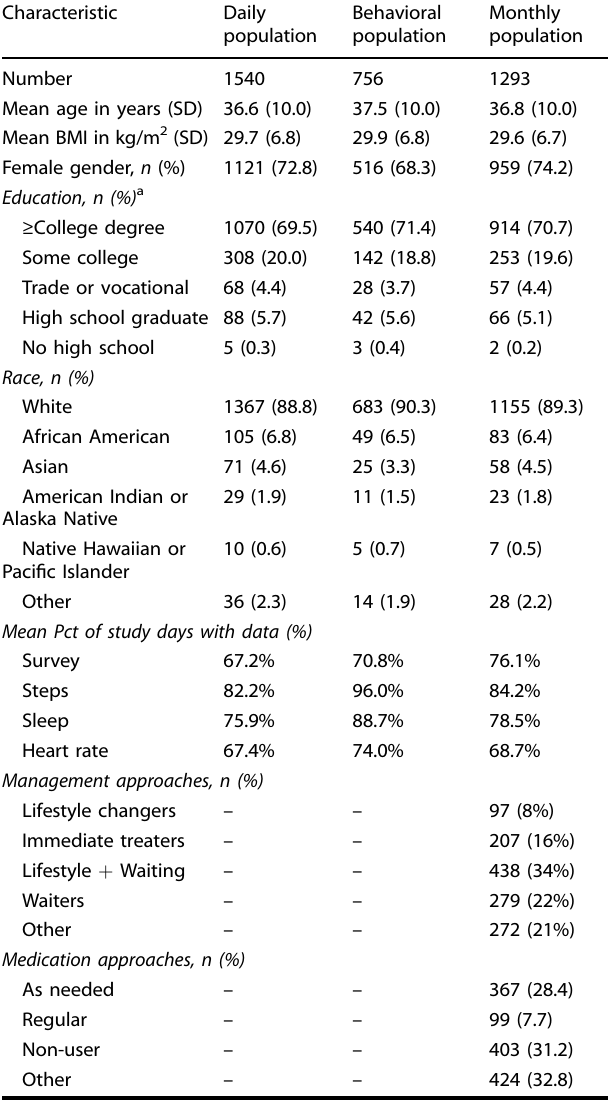
Table 1. Demographic and descriptive characteristics of